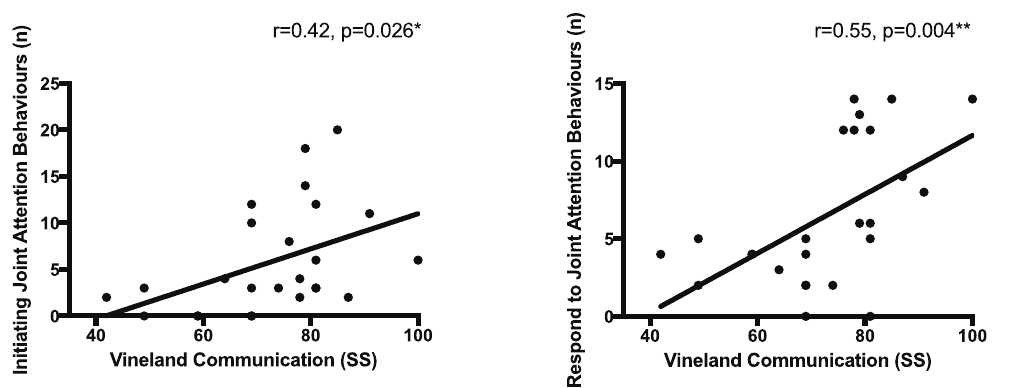
Fig 3. Relationship between JA behaviors and communication measurewithin the ASD